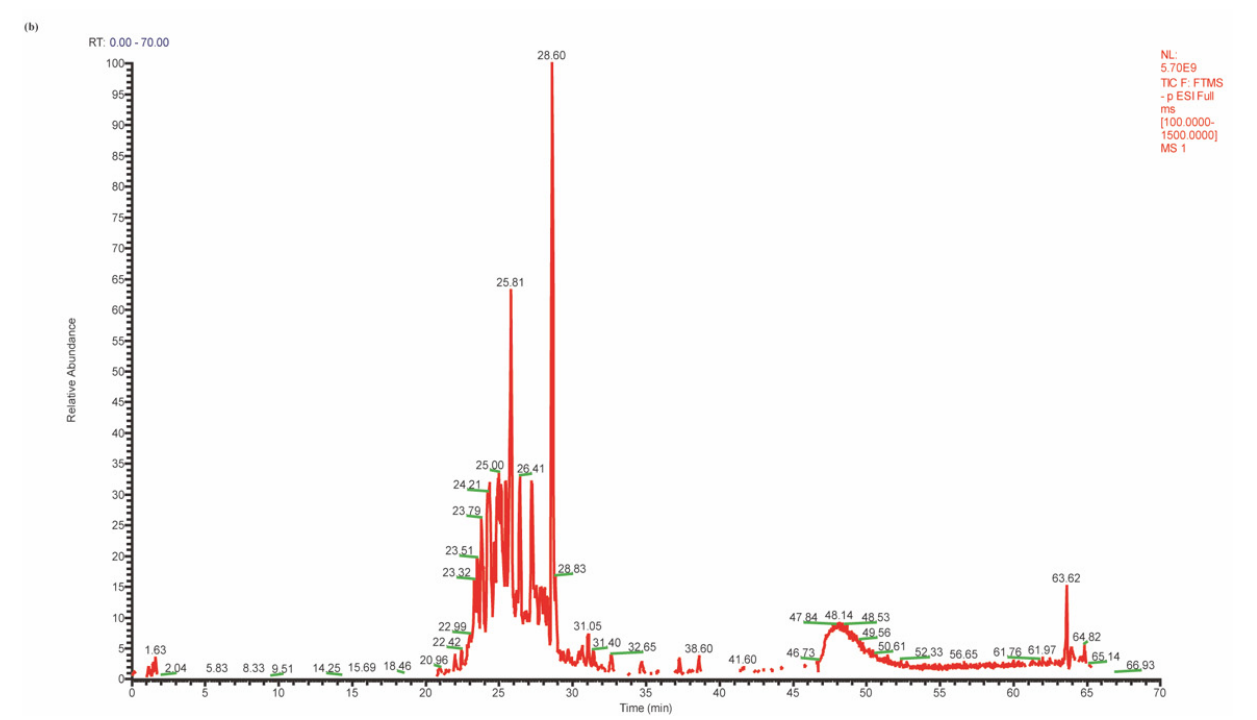
Figure 1. TIC diagram of the GBE in the positive ( a ) and negative ( b ) ion modes.